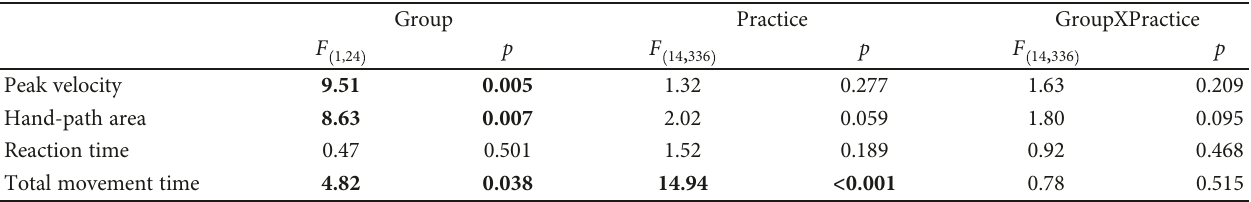
Table 1: Results of the repeated measure ANOVA, univariate tests of peak velocity, hand-path area, and reaction time comparing groups across practice.